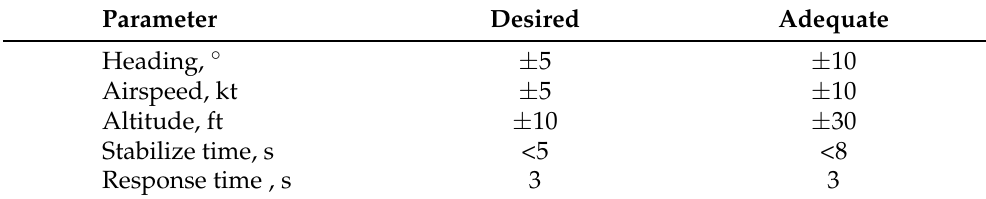
Table 6. Performance limits of pilot task for transit flights